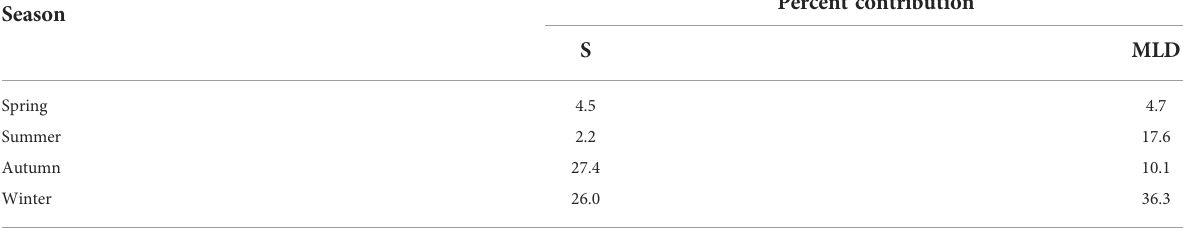
TABLE 3 Estimates of relative contributions of the S and MLD to the Maxent model for each season, the best run of T. japonicus